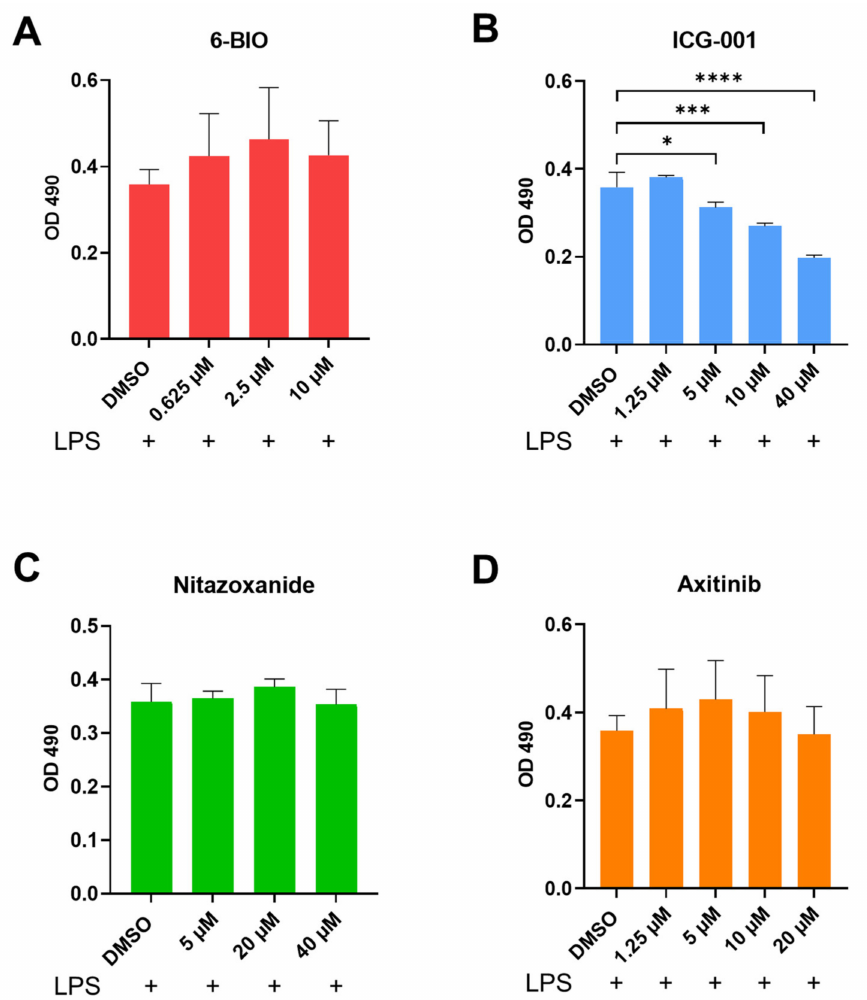
Figure 1. Results of MTS assays are shown as mean +/- SEM of the absorbance at OD 490 nm. The control is mature moDCs. Concentrations of the compounds in µ M are shown along the x-axis. These graphs are based on 3 individual experiments. * p ≤ 0.05, *** p ≤ 0.001, **** p ≤ 0.0001 by using one-way ANOVA followed by Tukey’s multiple comparisons test with 95% confidence